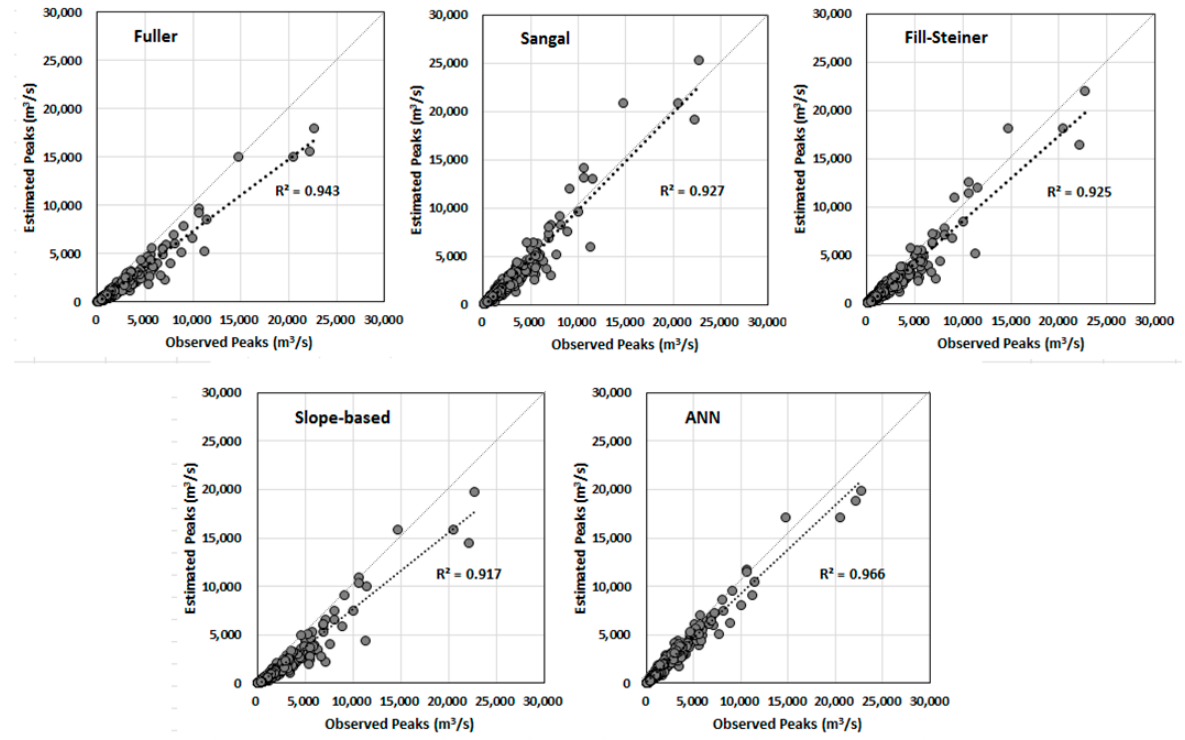
Figure 4. Comparison of the estimated and observed peak flows.